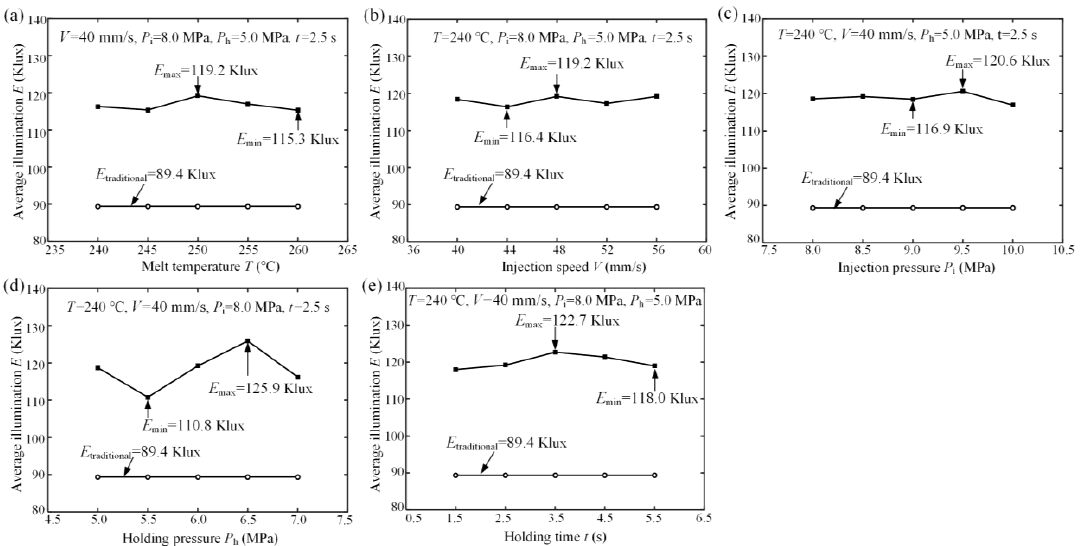
Figure 13. The average illuminations E of LED diffusion plates depending on micro injection molding process parameters: ( a ) melt temperature T ; ( b ) injection speed V ; ( c ) injection pressure P i ; ( d ) holding pressure P h ; ( e ) holding time t .